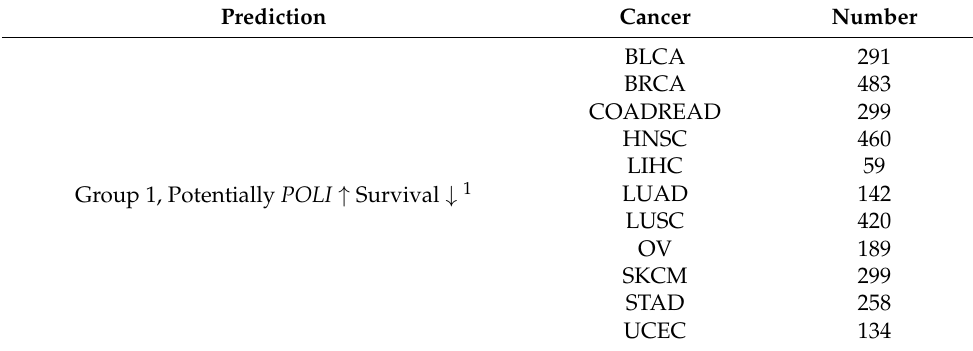
Table 2. The binary classification for 11 cancers based on the prognostic value of POLI -associated genes in CESC and